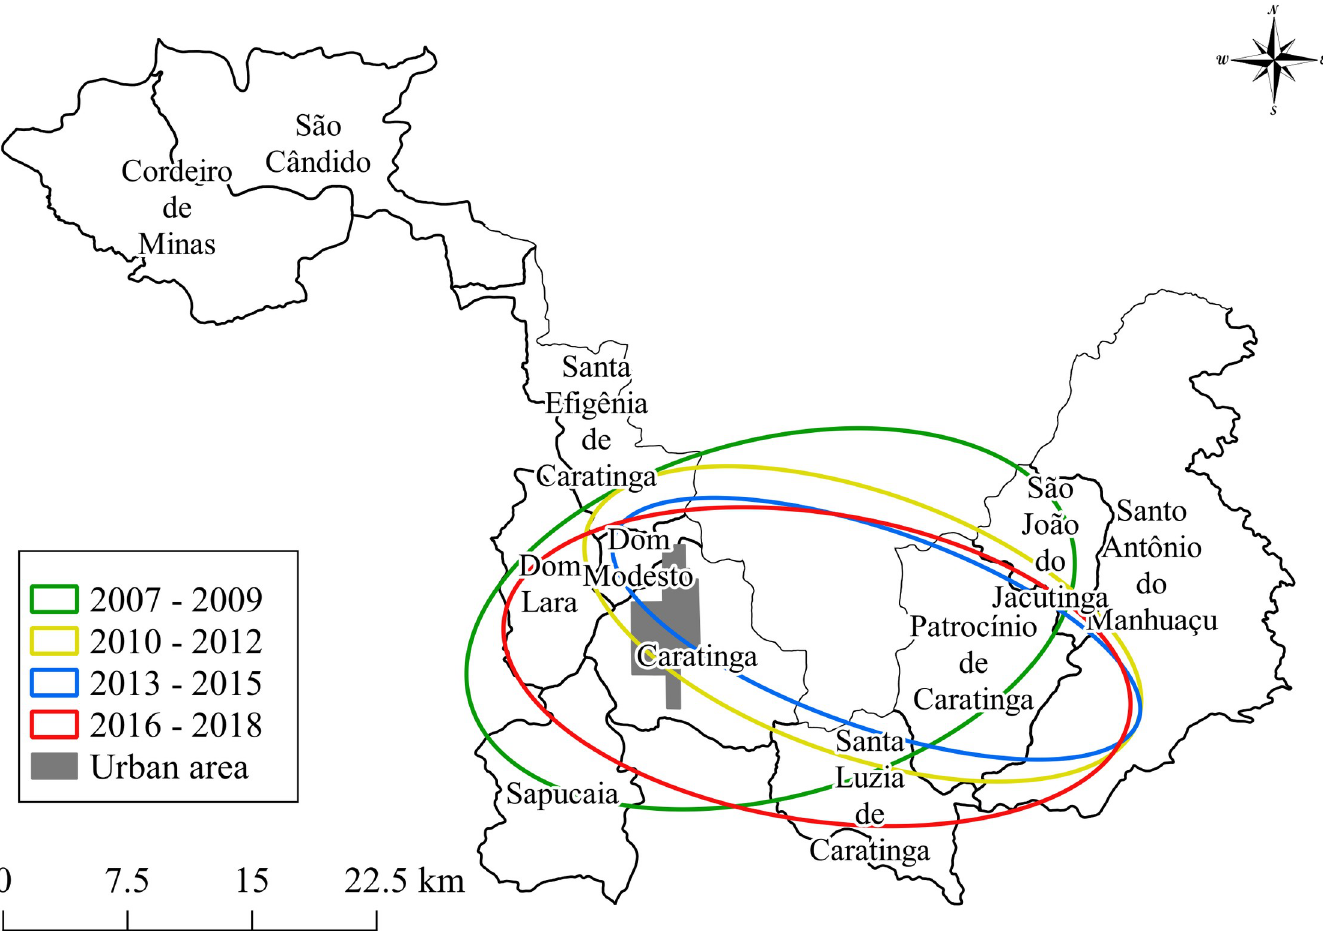
Fig 5. Ellipse showing the distribution of cases of ATL over a period of three years during the period 2007–2018 (www.ibge.gov.br).